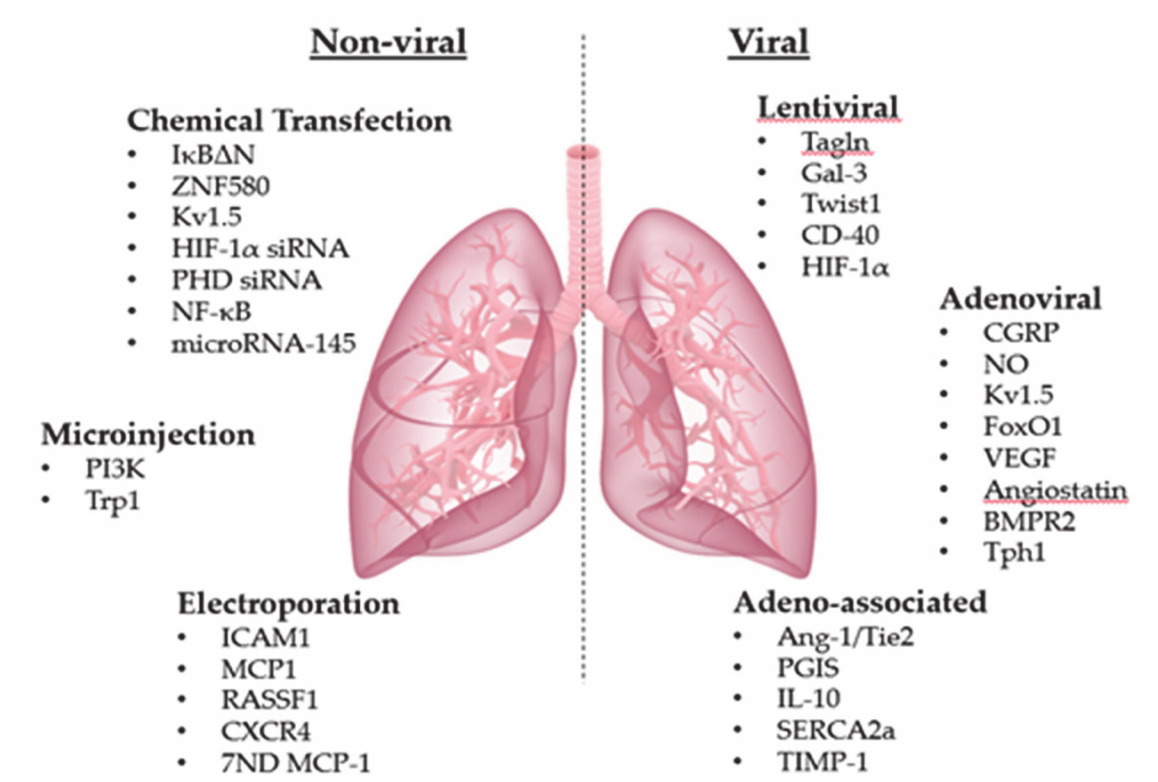
Figure 1. Non-viral and viral delivery systems in pulmonary vascular cells. 7-NH 2 terminus-deleted dominant negative inhibitor of the MCP-1 (7ND MCP-1); Angiopoietin 1 (Ang-1); Angiotensin II (Ang II); Bone morphogenetic protein